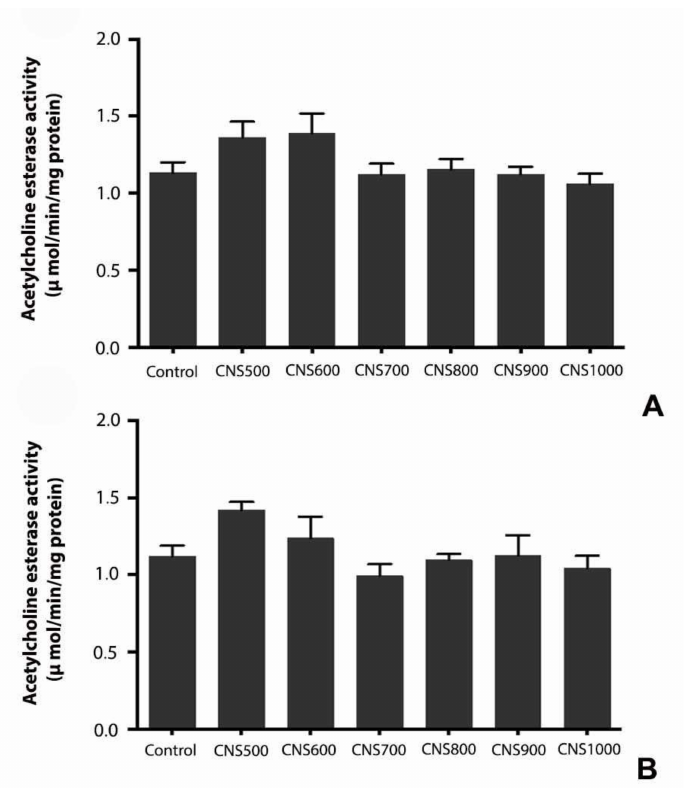
Figure 7. Estimation of acetylcholine esterase (AChE) activity in response to dietary exposure to CNS500, CNS600, CNS700, CNS800, CNS900, and CNS1000 CNSs for 25 days at 1000 µ g/mL in ( A ) male and ( B ) female flies. AChE activity was estimated using Ellman’s method and values are represented as mean ± SEM; statistical significance was set at p < 0.05 when compared to control (n = 3 and 25 flies per treatment